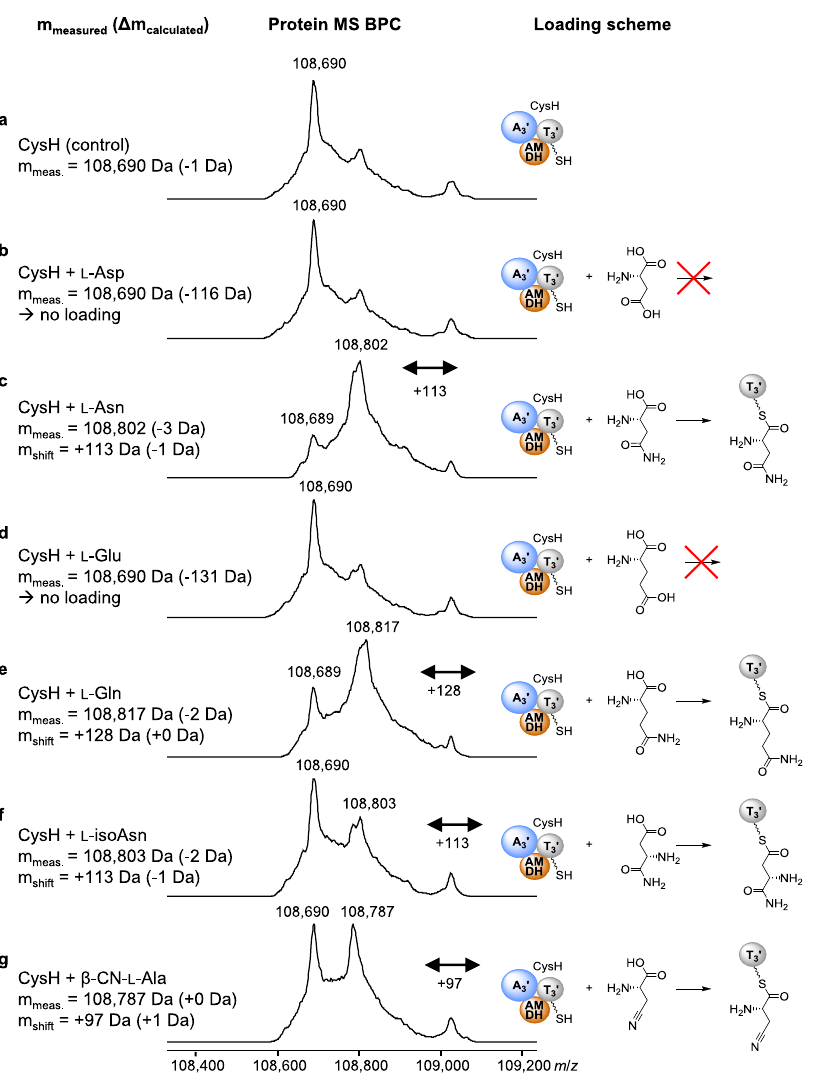
Fig. 2 Substrate speci fi city of CysH. Observed mass shifts in deconvoluted protein MS BPCs reveal loading of L -asparagine ( c ), L -glutamine ( e ), L -isoasparagine ( f ), and β -cyano- L -alanine ( g ) onto CysH. L -aspartic acid ( b ) and L -glutamic acid ( d ) were not accepted by CysH (control: a ). Blue sphere: adenylation domain; gray sphere: thiolation domain; orange sphere: AMDH